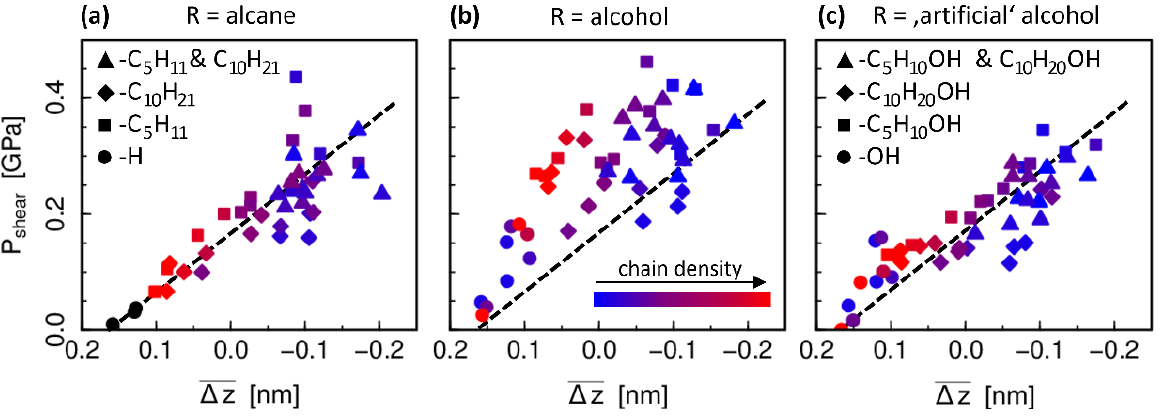
Figure 5. Shear stress as a function of the steric hindrance parameter ∆ z as defined in Equation (2) for all systems with ( a ) non-polar and ( b ) polar terminations, as well as ( c ) artificial alcohol terminations with adapted charges of the OH-functional groups (see text for further details). Symbols refer to different chain lengths (legend in ( c ) also holds for panel ( b )) and the color code indicates the chain density (same in ( a – c )), where only the longer chain type is taken into account here for the cases with mixed chain lengths (see text for further discussion). Black symbols in ( a ) refer to the fully H-terminated a-C systems. The dashed line is a guide to the eye for the slope of the correlation in ( a ) and is repeated in ( b , c ) for comparison.